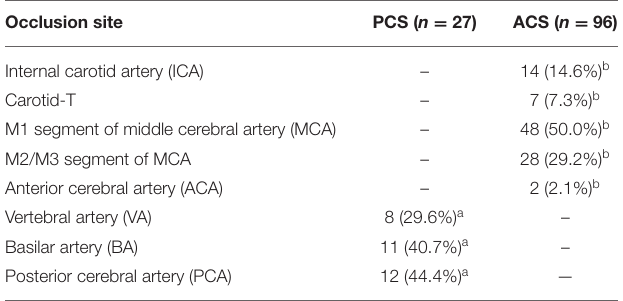
TABLE 4 | Distribution of large vessel occlusion (LVO) in the LVO patient cohort. Occlusion